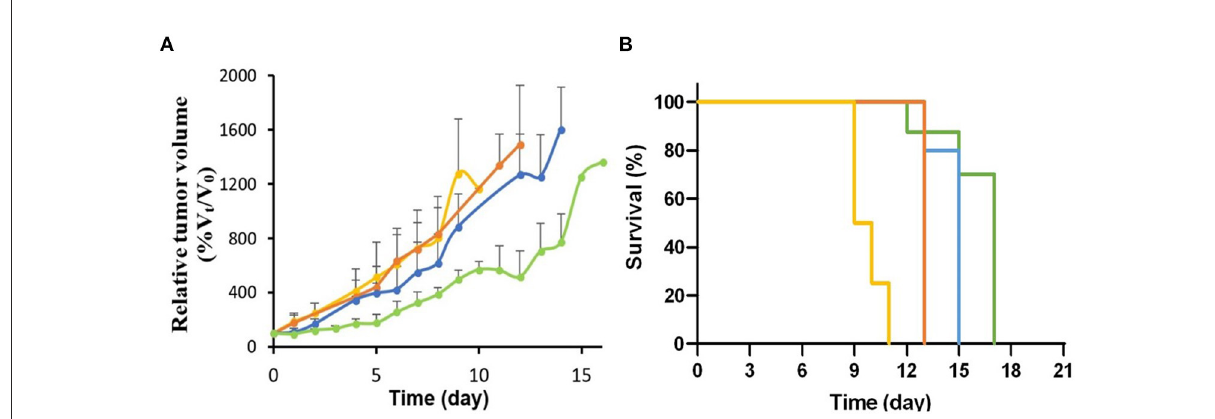
FIGURE8 (A) Relative tumor growth (%V t /V 0 ) after treatment with 70 MBq ( n = 4, blue line) and 137 MBq ( n = 5, green line) of [ 64 Cu]NOTA-C3-TP compared to [ Nat Cu]NOTA-C3-TP ( p < 0.001, n = 5, orange line) and the vehicle ( p < 0.001, n = 5, yellow line). (B) Survival curves between these